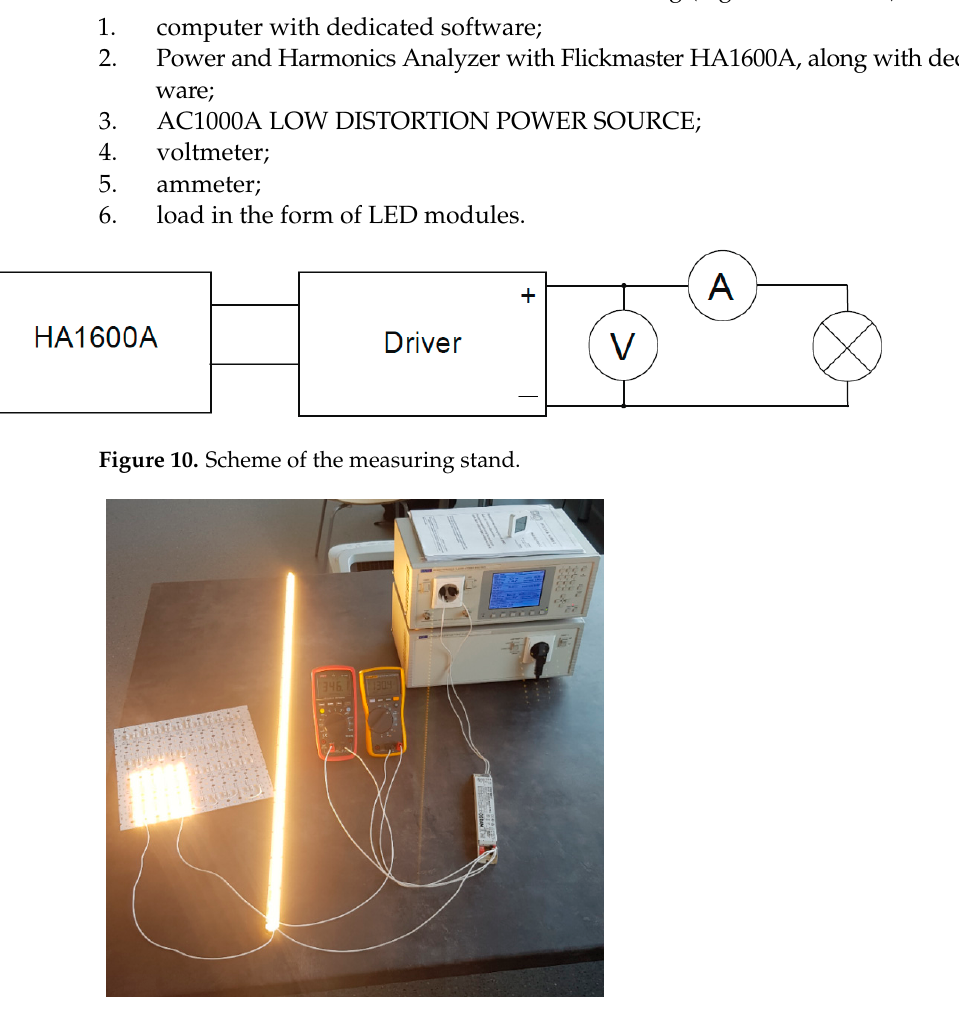
Figure 11. Photo of the station during measurements of LED power supplies. The photo shows the OPTOTRONIC OT FIT 65/220-240/350 D CS L power supply with load